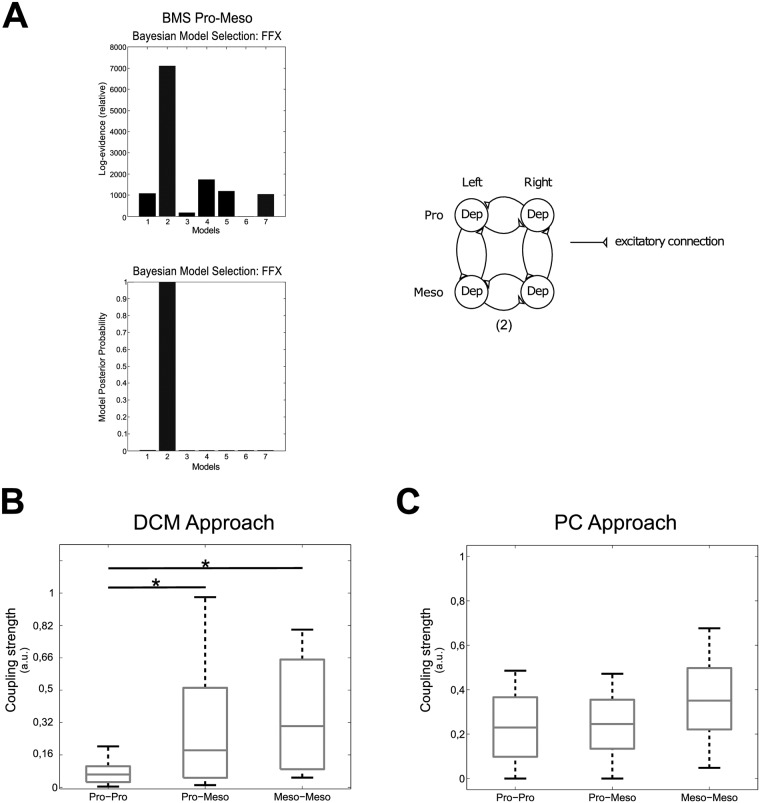
Connectivity pro-meso.A: BMS results for pro-meso DCM (left) and winning model structure (right). B: Boxplot showing the connectivity strengths for the DCM approach. The connectivity strengths were calculated for intervals that were pre-identified as phase-coupled by the PC approach. C: Boxplot showing the connectivity strengths for the PC approach. Pro-Pro denotes coupling between both sides of the prothoracic and meso-meso the one between the both sides of the mesothoracic ganglion. Pro-Meso represents the intersegmental coupling between the pro- and the mesothoracic ganglia. * denotes statistical significant differences.